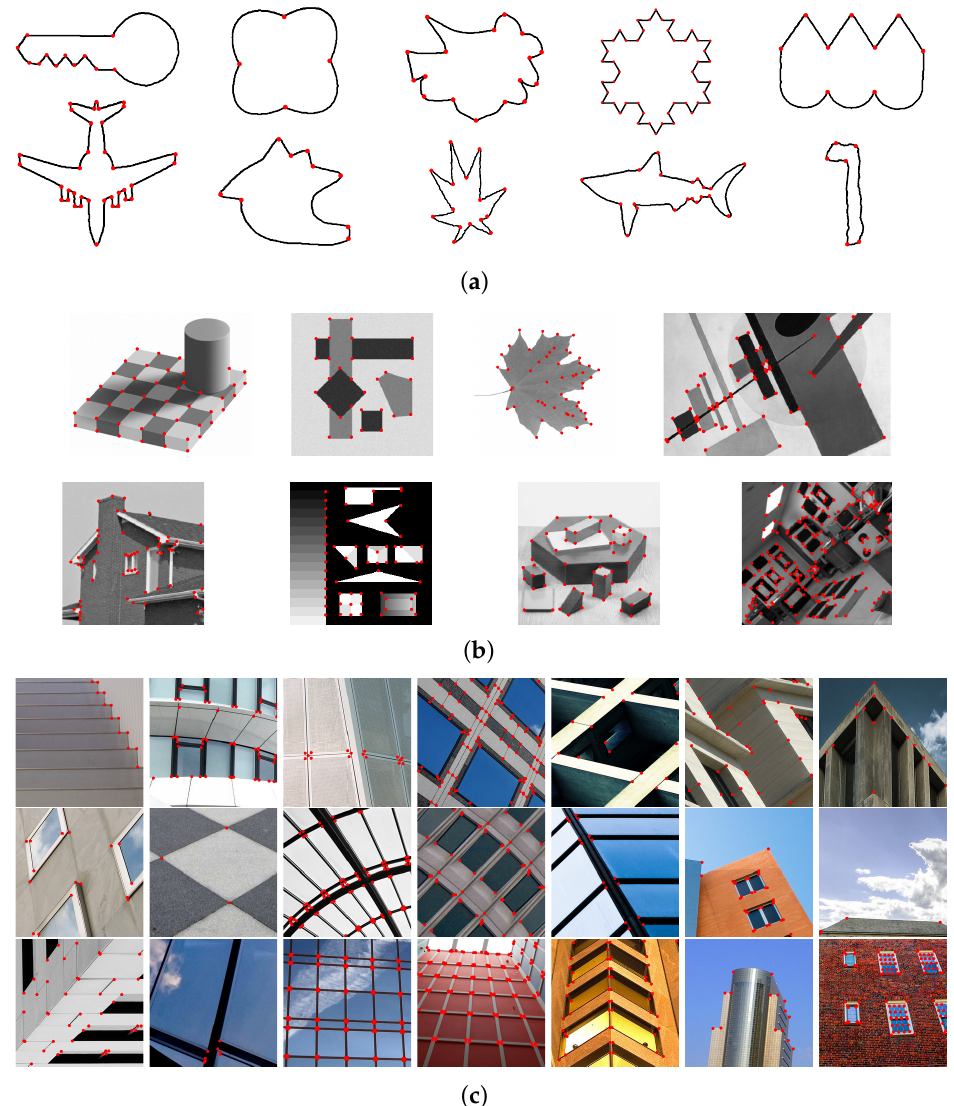
Figure 1. Benchmark datasets constructed and used to conduct our evaluation, where the ground- truth corners were manually labeled by us and marked with dots. ( a ) Dataset 1; ( b ) Dataset 2; ( c ) Dataset